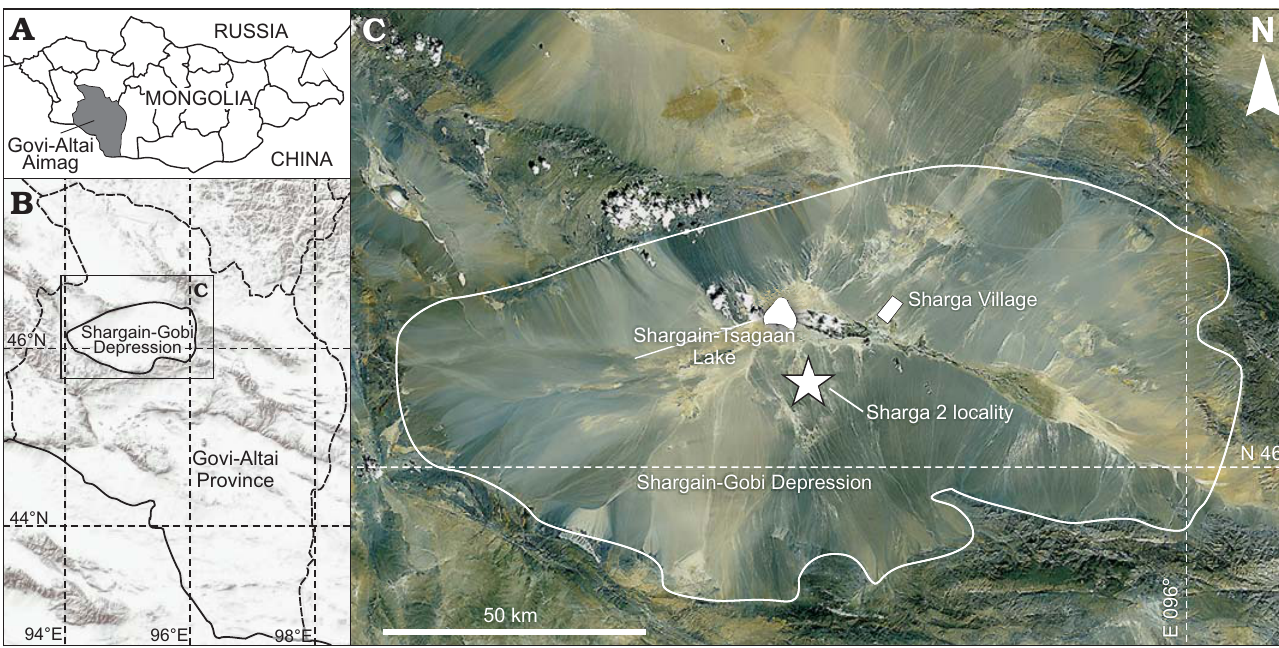
Fig. 1. Map showing location of Govi-Altai Aimag in south-western Mongolia ( A ) and Shargain Gobi Depression within Govi-Altai Province ( B ). C . Satellite image of the Sharga Village area, where Shargainosorex angustirostris gen. et sp. nov. was